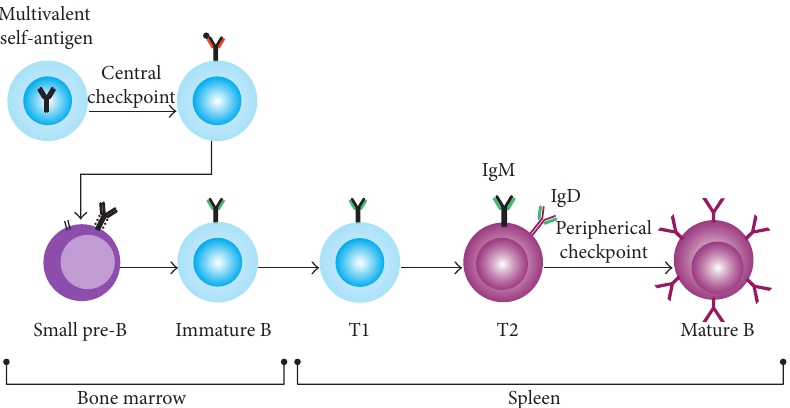
Figure 6: Receptor editing as a major mechanism of central tolerance in B cells. Receptor editing is a major mechanism of central tolerance in B cells. Immature B cells in the bone marrow that encounter multivalent self-antigens revert to the small pre-B stage, continue to rearrange k and, if necessary, l light chain genes, and generate newly B cells that have a novel light chain that is no longer self-reactive. Immature B cells with novel light chains that are no longer part of a self-reactive B cell receptor then migrate to the periphery as T1 B cells where they mature into newly generated IgM and IgD expressing recirculating T2 B cells and, then, into mature recirculating B